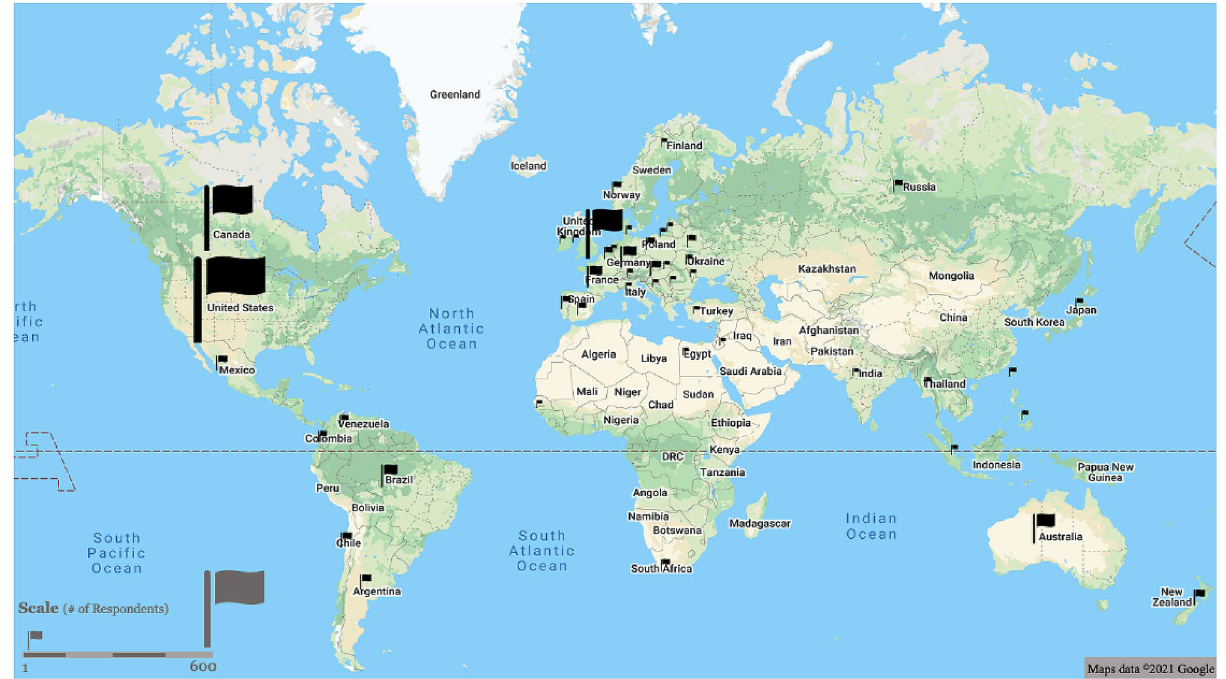
Figure 1. Responses were collected from 47 countries across 6 continents. Locations of the survey responders, by IP address. Responses were collected from over 47 countries and the size of each flag symbol on the map is proportional to the number of responses received from the region. For reference, the number of responses from the US was 687, from the United Kingdom was 138, from Brazil was 7, and from New Zealand was 2. Maps data ©2021 Google.